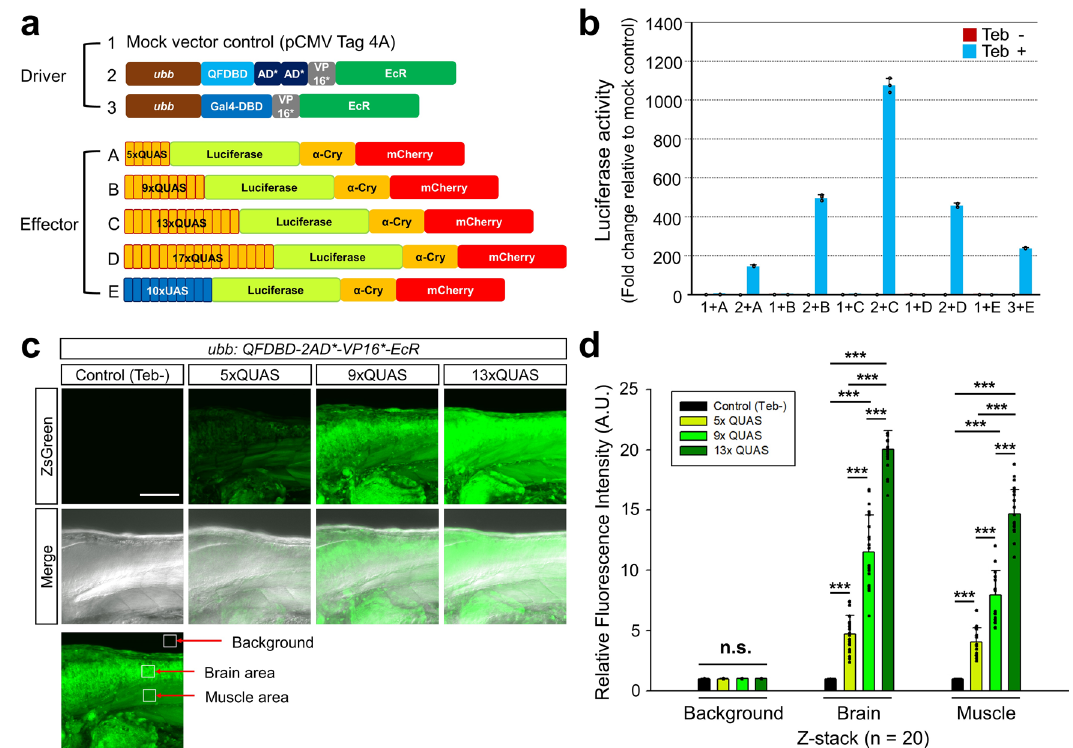
Fig. 4 Optimization of QUAS repeats for stepwise transgene overexpression. a Schematic drawing of driver and effector constructs. b Luciferase activities measured in HEK293 cells transiently transfected with the indicated driver and effector combinations. HEK293 cells were treated with 10 µ M of Teb 24 h after transfection and then raised for another 24 h before harvest. Note that the combination of QF ( “ 2 ” ) and 13xQUAS ( “ C ” ) was the best at potentiating transgene induction. c Representative Z-stacking image of embryos at 3 dpf exposed to 10 μ M of Teb for 24 h. Embryo harboring both the driver and 13xQUAS-regulated ZsGreen effector without treatment of Teb was used as a negative control, which could be easily selected by observation of red and green fl uorescence in the lens. d The areas demarcated by open white boxes in ( c ) represented relative fl uorescent intensities in the brain and muscle being evaluated in comparison to the level of control background intensity without Teb treatment, which was assumed as 1 arbitrary unit. Z-stacking images from randomly collected embryos ( n = 20) were used to measure the expression level of ZsGreen regulated by 5x, 9x, and 13xQUAS. Error bars stand for the standard deviation. P -value indicated with (***) stands for < 0.001. Abbreviations: A.U.; arbitrary unit, n.s.; not signi fi cant, Teb; tebufenozide. Scale bar: 100 μ